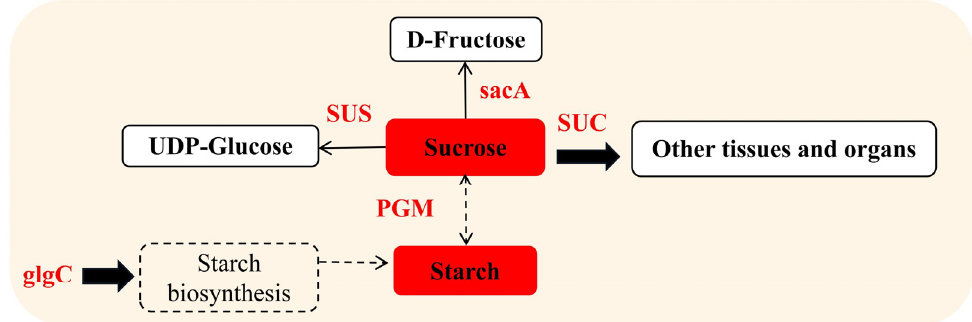
Figure 8. Blue light regulates sucrose and starch concentrations and related enzyme activities in the hypocotyl. SacA, β -fructofuranosidase; SUS, sucrose synthase; SUC, sucrose transport protein; PGM, phosphoglucomutase; glgC, glucose-1-phosphoadenosyltransferase. The red solid squares represent the increased concentrations of sucrose and starch. The red text represents upregulated protein expression.